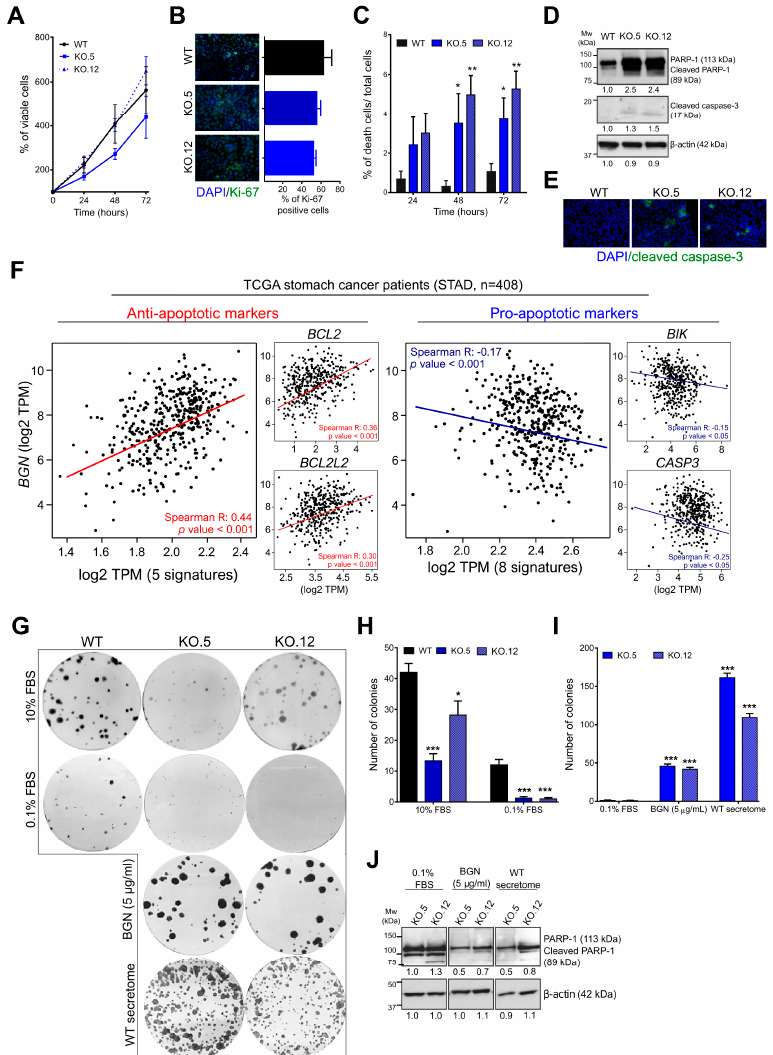
Figure 5. Loss of biglycan promotes GC cell death via induction of pro-apoptotic markers. ( A ) Trypan blue exclusion assay of viable cells over time. Loss of biglycan expression (clones KO.5 and KO.12) did not affect cell viability when compared to WT cells. ( B ) Ki-67 immunofluorescence (left panel) and percentage of ki-67 positive cells (right panel) relative of total amount of cells (DAPI stained cells). Images magnification at 200× ( C ) Percentage of cell death overtime assessed by trypan blue exclusion assay. Biglycan KO cells showed an increase of cell death comparing to WT control. ( D ) Immunoblot showing an increase of cleaved-PARP1 and caspase 3 in biglycan KO cells (clones KO.5 and KO.12). ( E ) Immunofluorescence analysis of cleaved-caspase 3 (green) and counterstained with DAPI to visualize the nuclei (blue). Cleaved-caspase 3 was only observed in KO cells. Images magnification at 200× ( F ) In silico analysis (TCGA, n = 408) demonstrating that GC patients with high levels of BGN expression also present a gene signature that is associated with increased anti-apoptotic markers ( BCL2, BCL2L2, BCL2A1, IQSEC2, BCL2L1) and inversely correlation with pro-apoptotic gene signatures (CASP3, CASP6, CASP5, CASP8, CASP10, FASN, BAK, BIK ). Gene correlation was performed using the Gene Expression Profiling Interactive